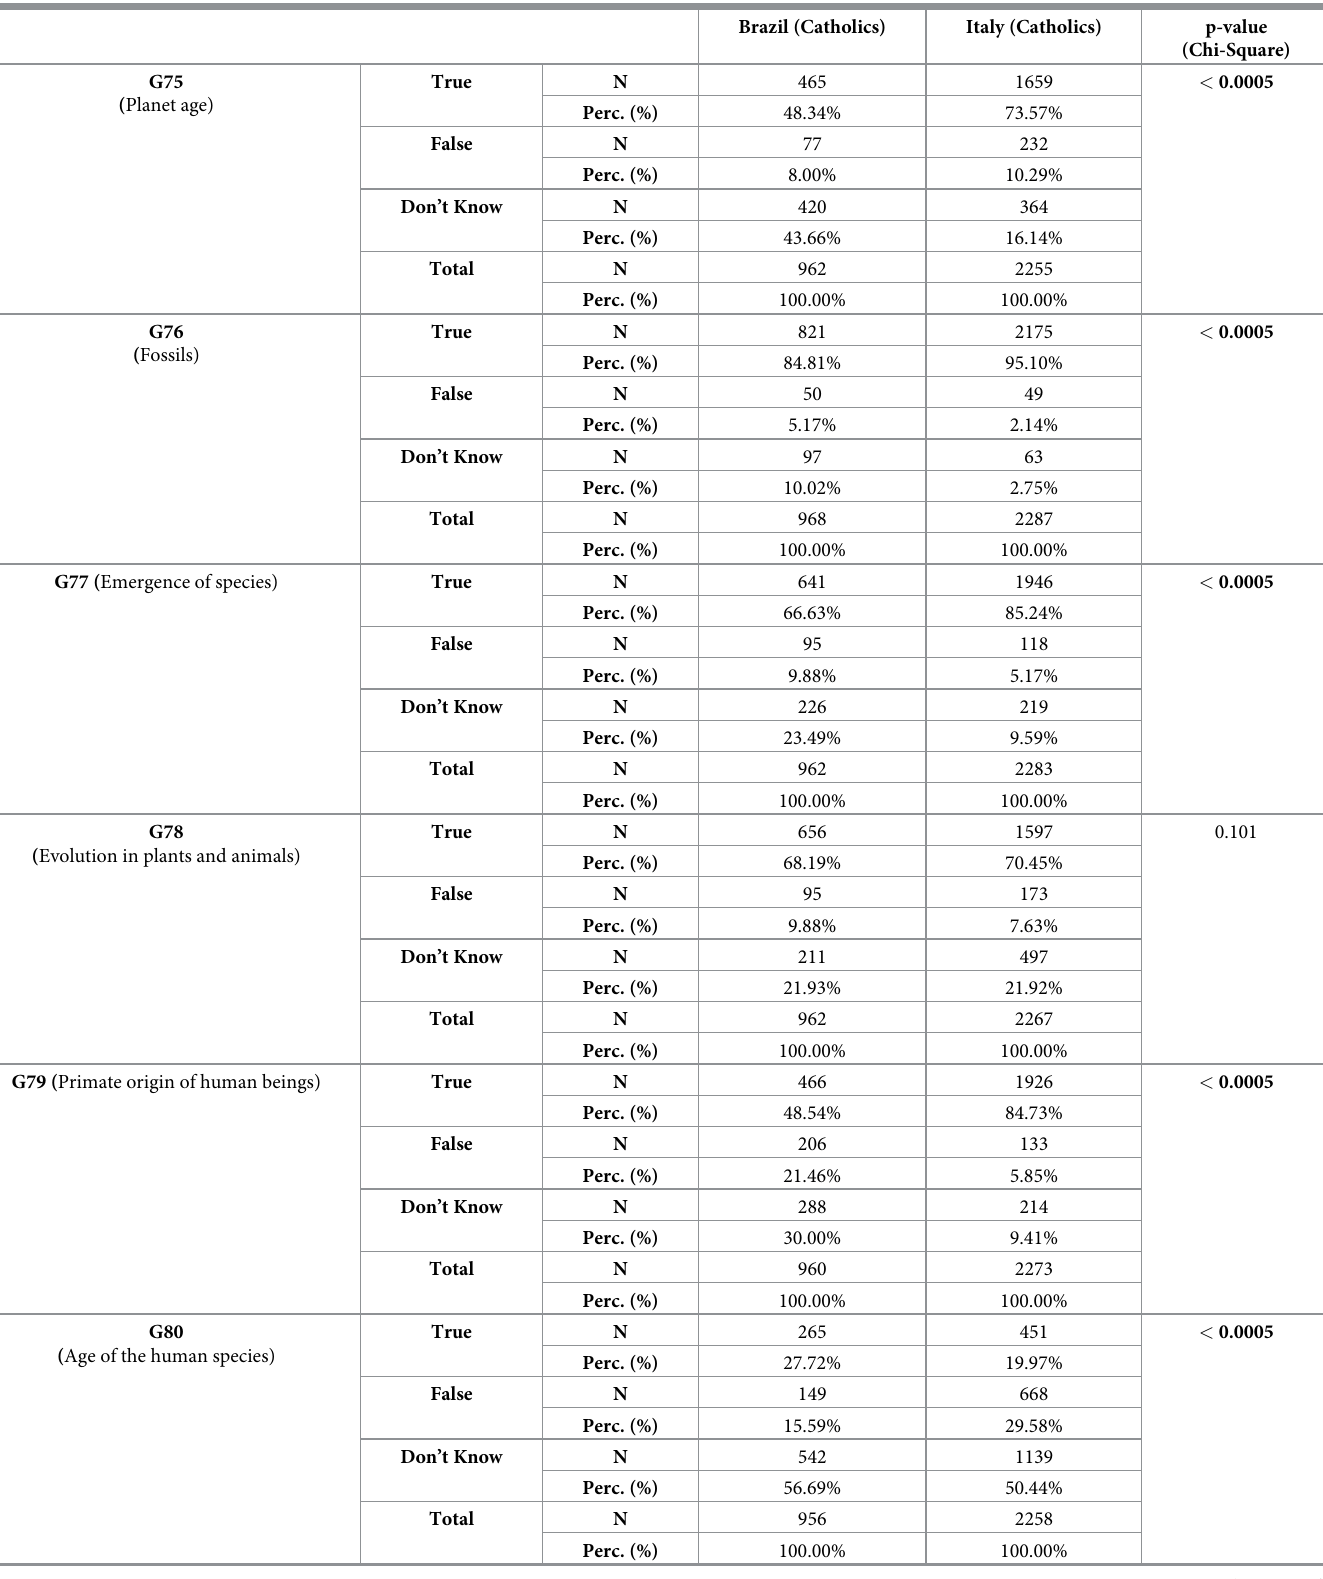
Table 1. Results by country (students declared as